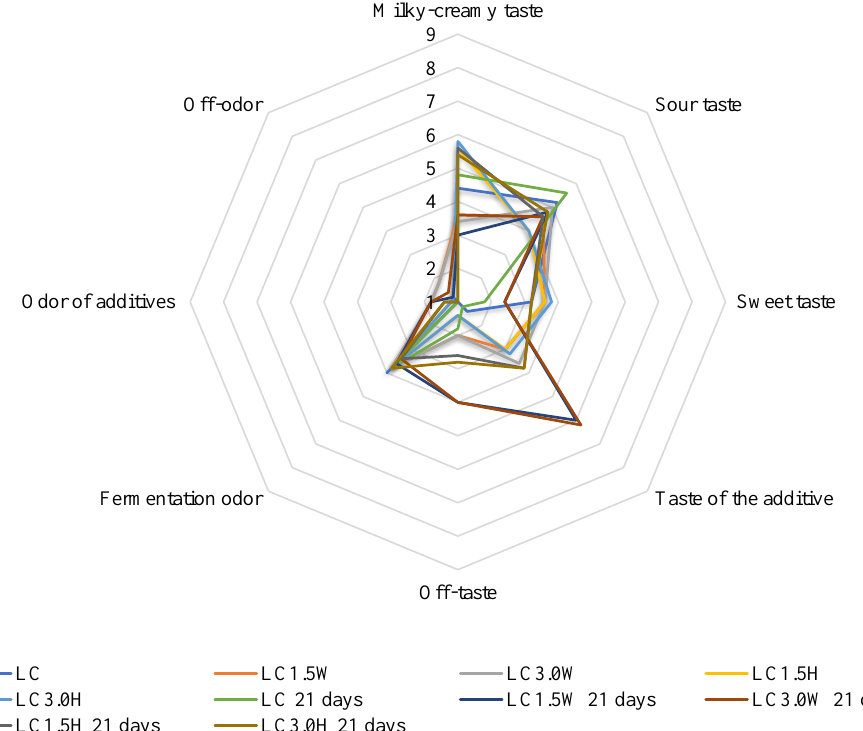
Figure 1. Effect of collagen addition on organoleptic parameters of milk fermented by L. casei after 1 and 21 days of cold storage. LC — control milk with Lacticaseibacillus casei ; LC1.5W — milk with 1.5% collagen and Lacticaseibacillus casei ; LC3.0W — milk with 3.0% collagen and Lacticaseibacillus casei ; LC1.5H — milk with 1.5% collagen hydrolysate and Lacticaseibacillus casei ; LC3.0H — milk with 3.0% collagen hydrolysate and Lacticaseibacillus casei.